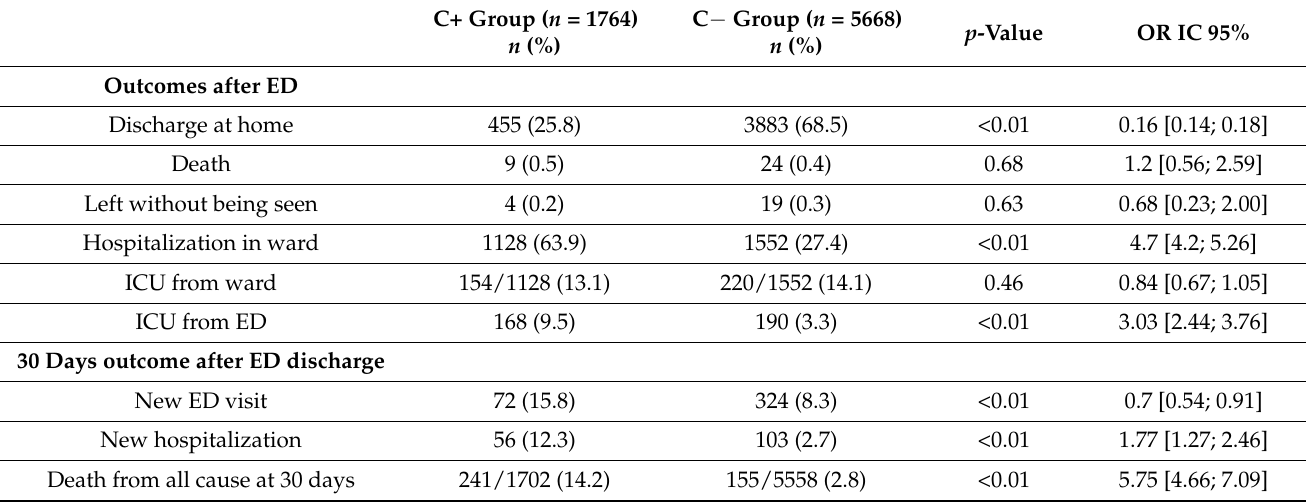
Table 7. Patient outcome after ED